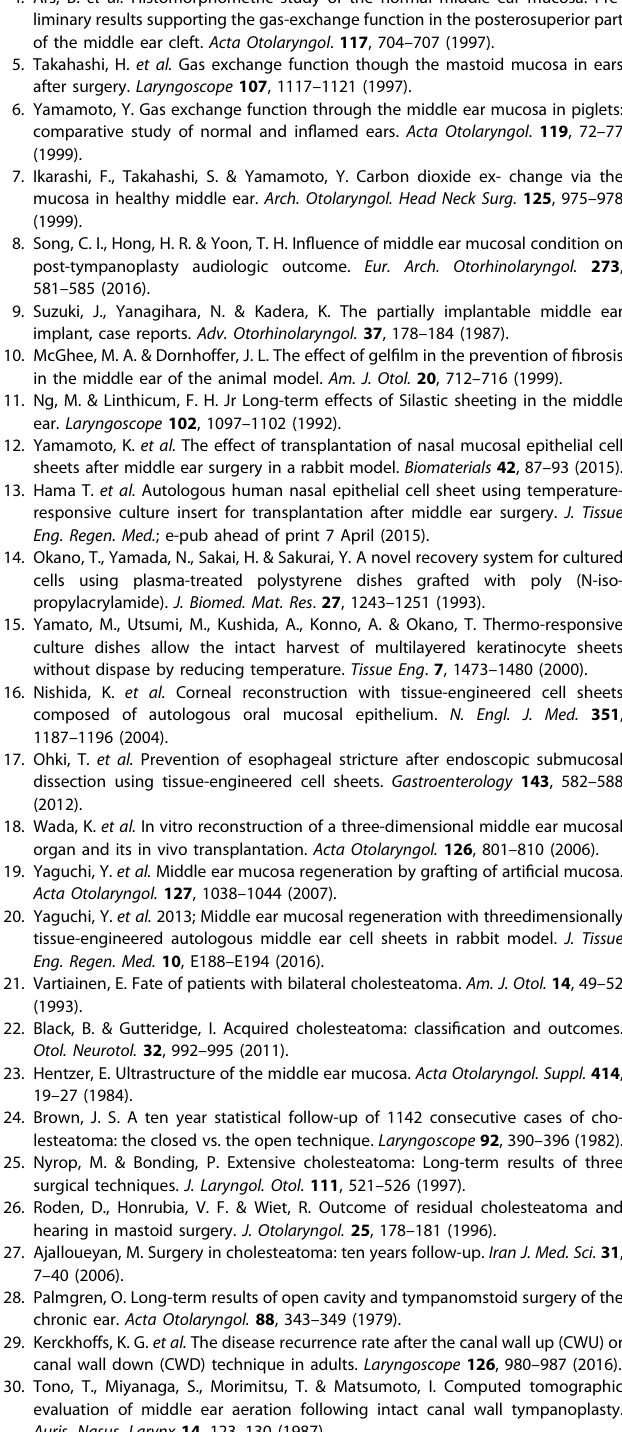
Fig. 6 Cell sheet transplantation for the patients with pars tensa cholesteatoma and adhesive otitis media. a Epithelium adhered around the stapes. b The adhered lesion is completely stripped away and removed. c A cells sheet is transplanted around the stapes using the earlier- described device. d A hybrid graft material composed of cartilage and a cell sheet is placed onto the transplant site. Tympanoplasty is performed so that the cell sheet faces the tympanic cavity side. e The cell sheet is situated on the back surface of the cartilage, as indicated by the red star . f Diagram of the coronal cross-section. The cell sheet around the stapes is depicted in blue , while the cell sheet on the rear surface of the reconstructed tympanic membrane is in red . With the objective of preventing re-adhesion of the tympanic membrane, cell sheet transplantation was performed around the stapes and on the rear surface of the reconstructed tympanic